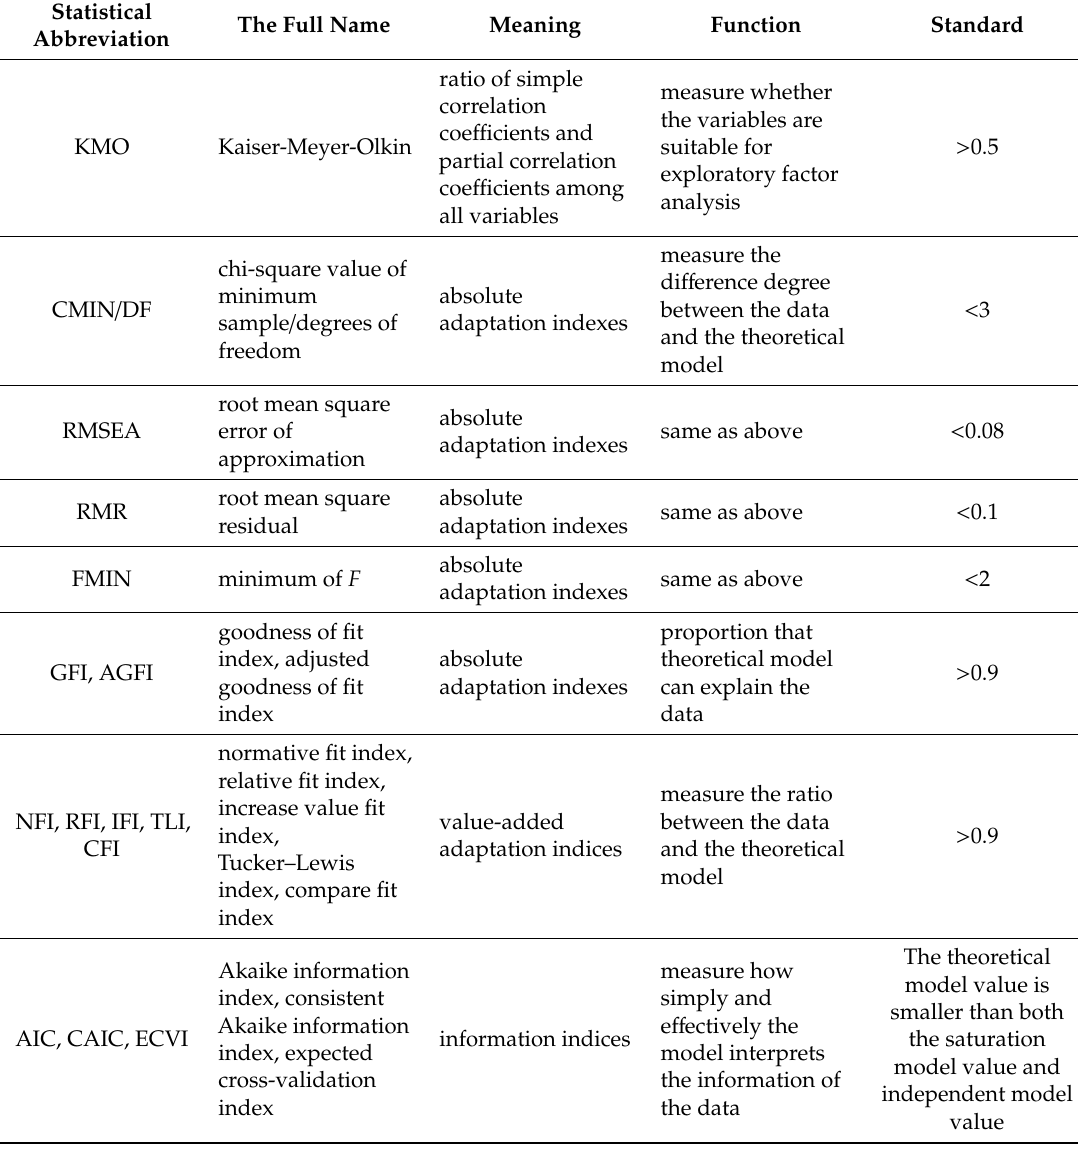
Table 2. Statistical